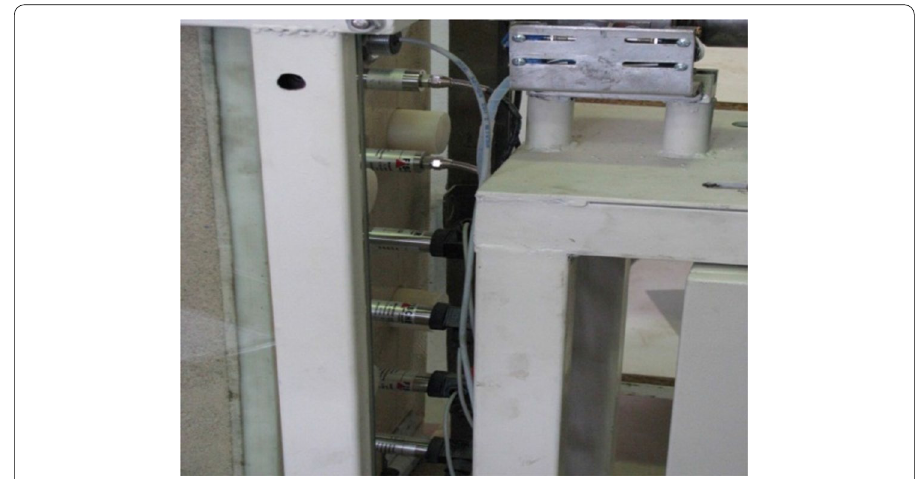
Fig. 3 Detail of the installation of the pressure cells